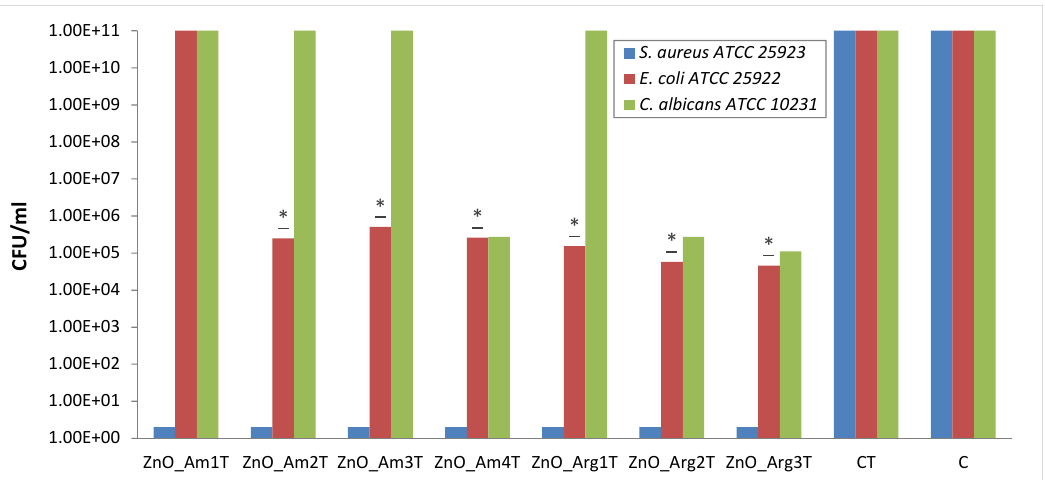
Figure 11. Graphical representation of the log10 values of colony forming units (CFU)/mL representing the viable cells of tested strains after the 18 h contact with tested samples; * 0.05 ≥ P(T ≤ t) > 0.001 significant evidence of inhibitory effect manifested by textile products on bacterial growth and multiplication. CT–control with untreated textile; C–control.